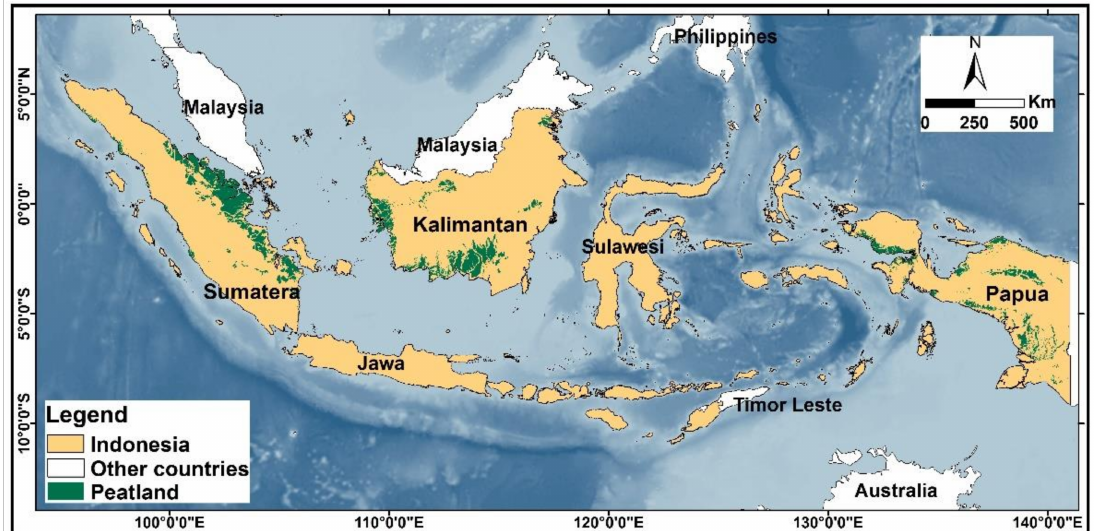
Figure 1. Main peatland distribution in Indonesia, in the four big islands of Sumatera (43.5%), Kalimantan (33.8%), Papua (22.4%) and Sulawesi